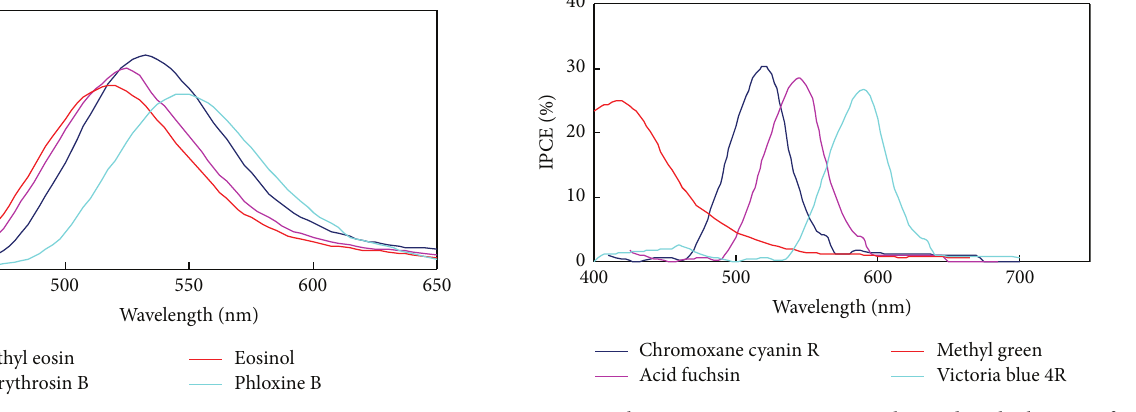
Figure 5: Action spectrum of incident photon-to-current conver- sion efficiencies (IPCE) obtained for nanocrystalline TiO 2 solar cells sensitized by fluorone based dyes.